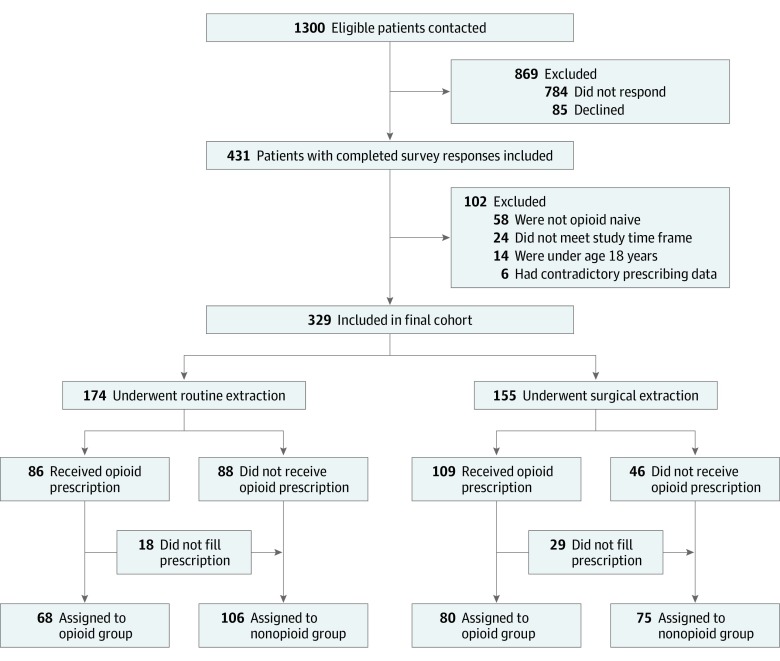
Patient Flow DiagramOf the 1300 eligible patients, 784 could not be contacted and 85 refused to participate. An additional 102 patients were excluded for reasons such as being younger than 18 years, having the procedure or response outside of the study period, and using preoperative opioids. The final cohort comprised 329 patients assigned to the opioid and nonopioid groups. Sensitivity analyses were conducted in which these patients were assigned to the opioid group and another set of analyses in which they were excluded.